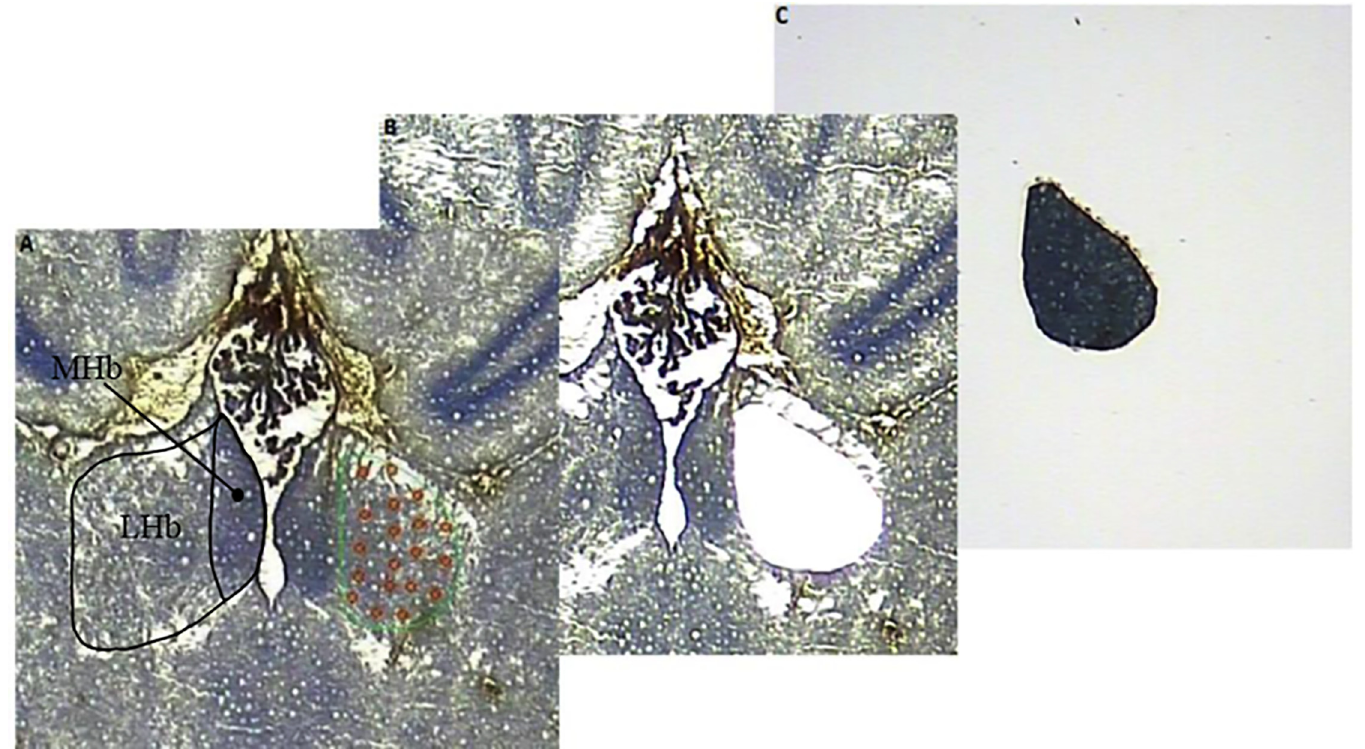
Fig 1. Illustration of the LCM procedure. Horizontal section at 20X magnification of the rat habenular complex. (A) The LHb marked in green for LCM and the MHb marked in black for illustration. (B) The cap was placed on the tissue and the UV laser was activated to cut the LHb from beneath the membrane slide. An infrared laser then pulses through the top of the cap and interacts with a transfer film, which then melts and binds to the LHb. (C) Subsequently, the cap was removed from the tissue, having separated the LHb from the remaining habenular tissue.